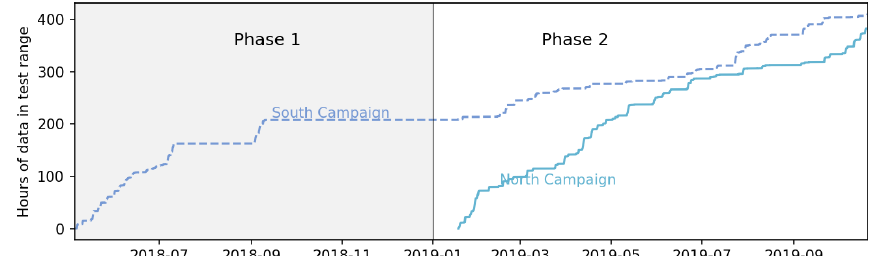
Figure 2. Data accumulation for both phases and campaigns. For both north and south, we consider only data that are in the range of wind directions for which the control turbine would be activated and the data are usable in that they contain no faults or issues with any sensor used in control or analysis.